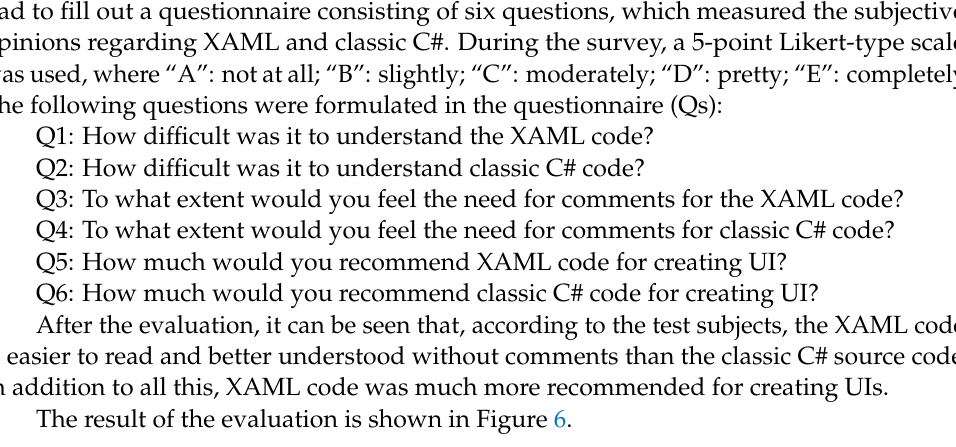
( b ) Figure 5. Distribution of incorrect answer (count) based on XAML ( a ) and classic C# ( b ). The normality results of the traditional knowledge level tests measured are signi fi - cant (XAML approach: W (36) = 0.879, p < 0.001, classic C# approach: W (36) = 0.857, p <